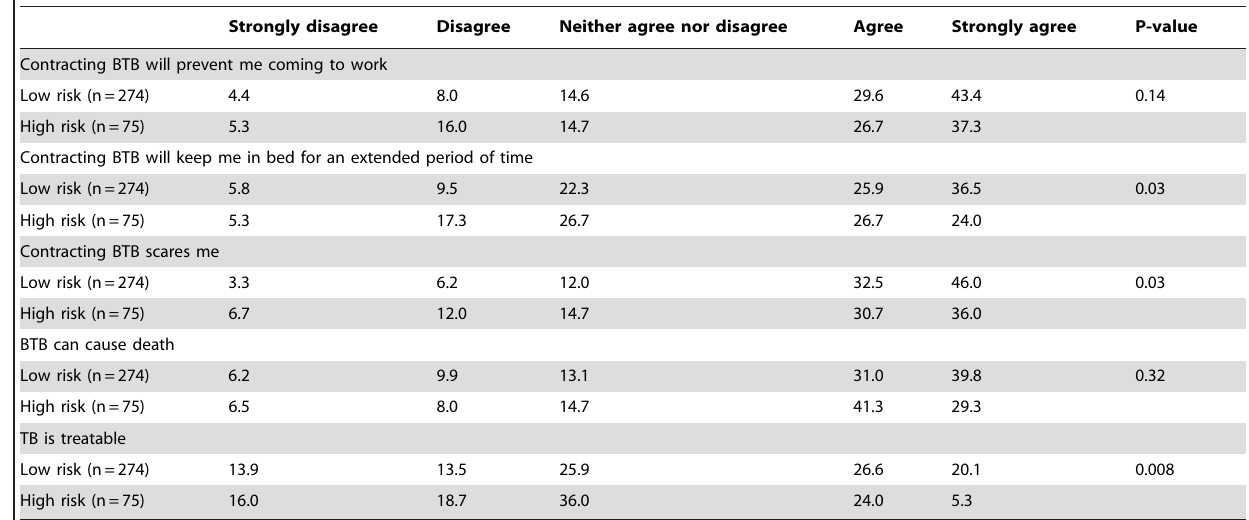
Table 5. Perceived severity (values are %).